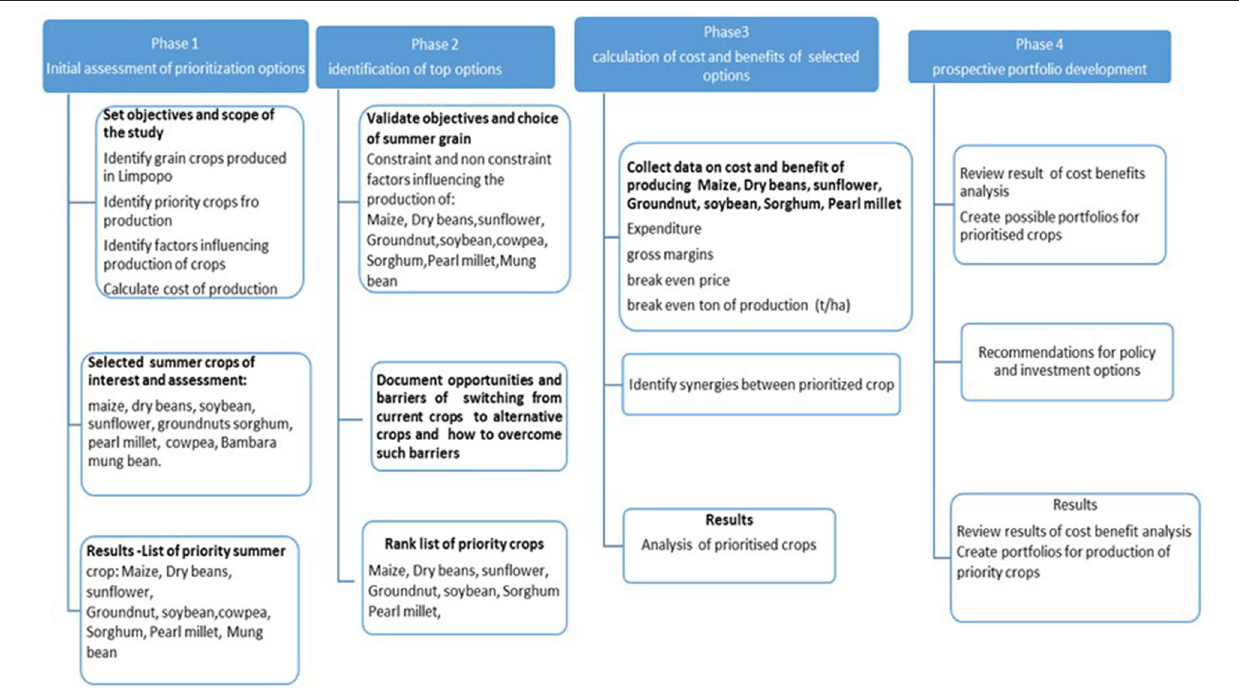
Frontiers in Sustainable Food Systems |